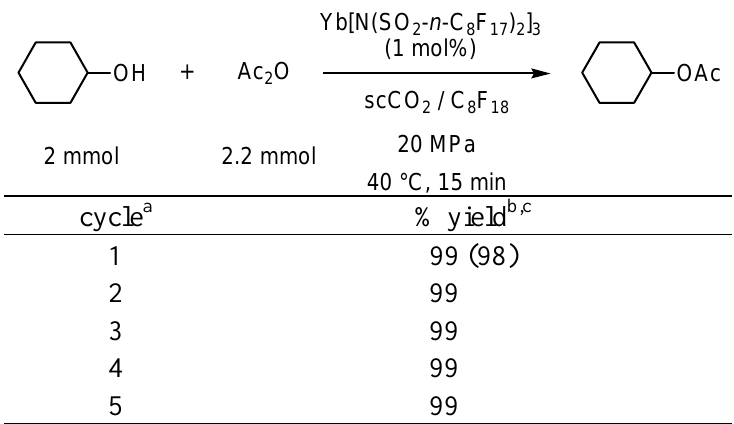
Table 6. Fluorous biphasic acetylation in scCO